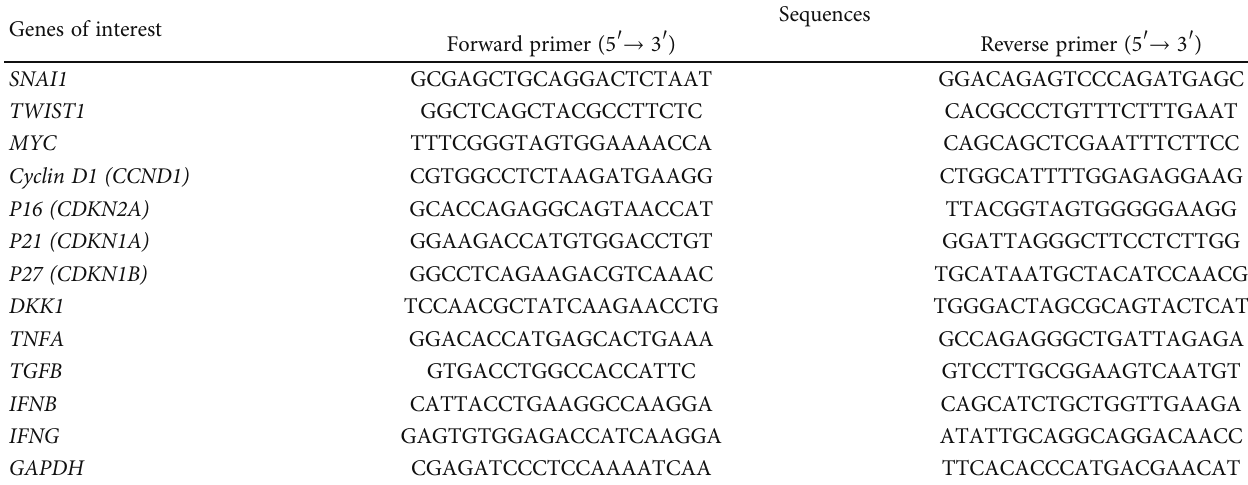
Table 1: List of